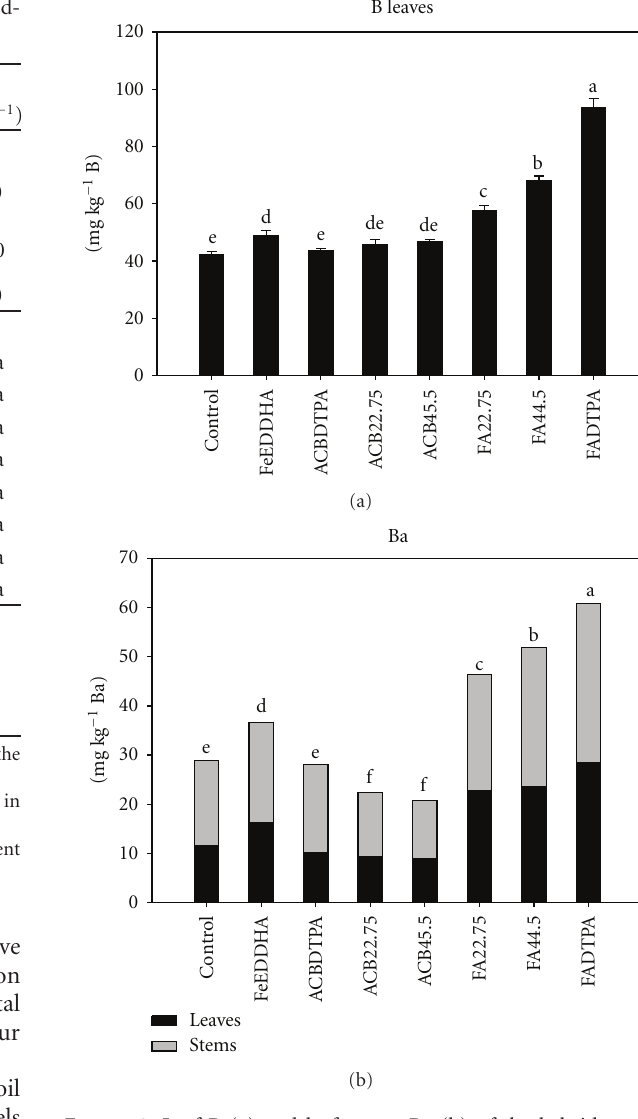
Figure 2: Leaf B (a) and leaf+ stem Ba (b) of the hybrid poplar clone OP-367 cultivated in soil amended with Fe EDDHA + UAN (urea ammoniumnitrate), fly ash+UAN, and composted biosolids. Means with the same letter are not significantly di ff erent at α = 0 . 05 level for combined leaf and stem material. Refer to Experimental Design and Statistical Analysis section for treatment